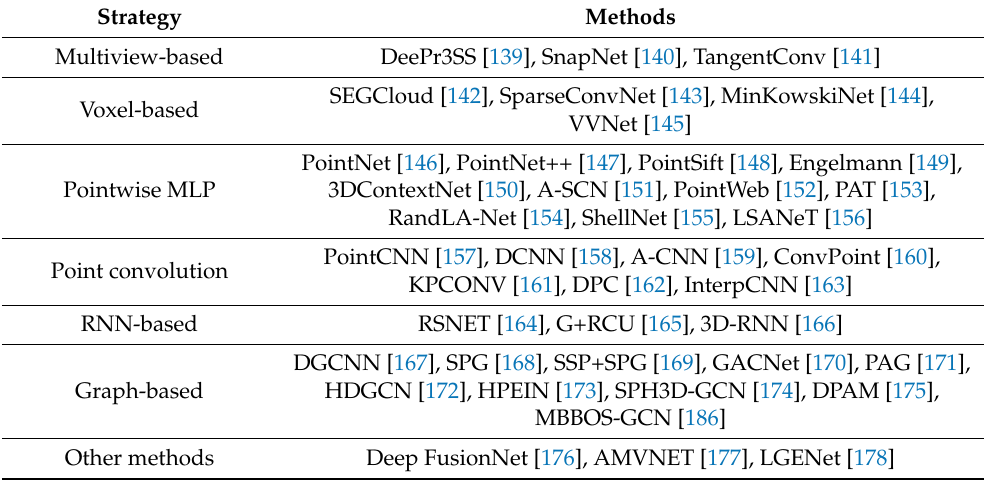
Table 8. Deep-learning semantic segmentation methods. Strategy Methods